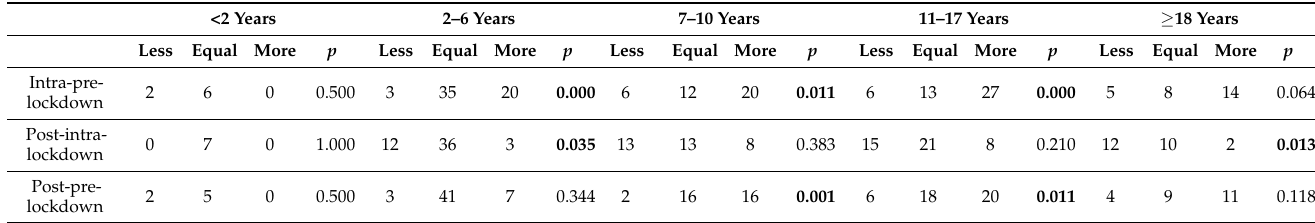
Table 4. Behavioral problems reported by